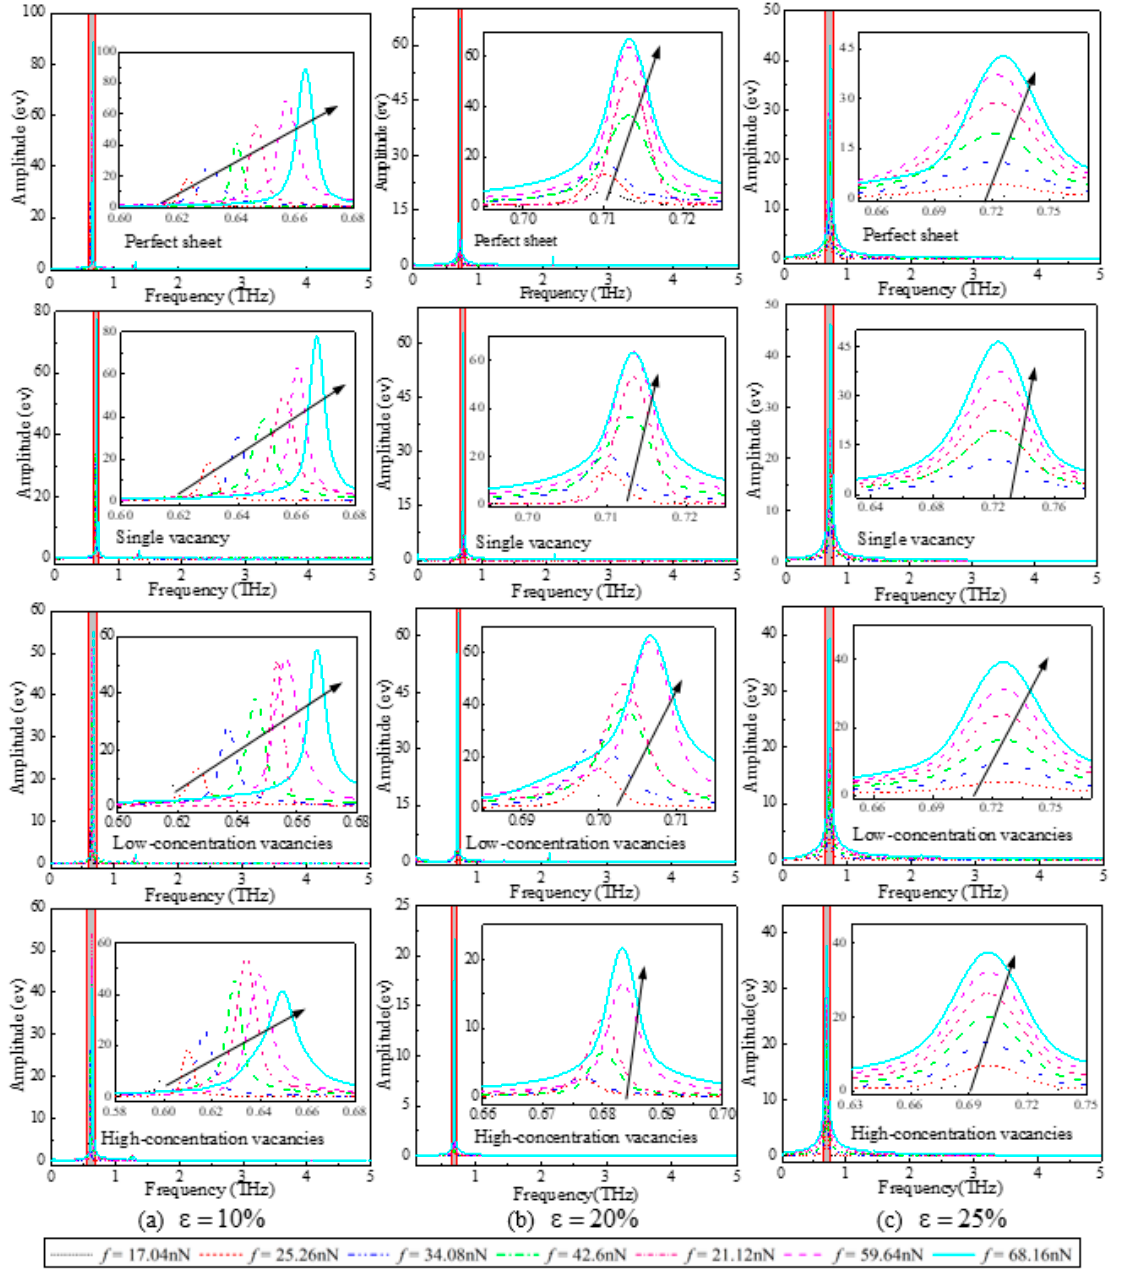
Figure 4. Frequency response curves of the SLGSs with different vacancy concentrations under ( a ) ε = 10%, ( b ) ε = 20%, and ( c ) ε = 25% pre-strained (the trend arrows represent the increasing external forces f